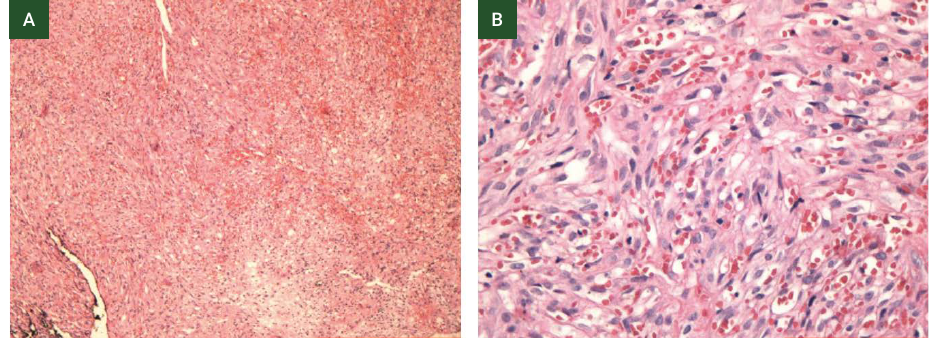
Figure 2. Low (A-100x) and high (B-400x) power microscopic view of Oral Kaposi’s Sarcoma, showing a hypercellular tumoral mass with atypical vascular channels and extravasated red blood cells (Hematoxylin &